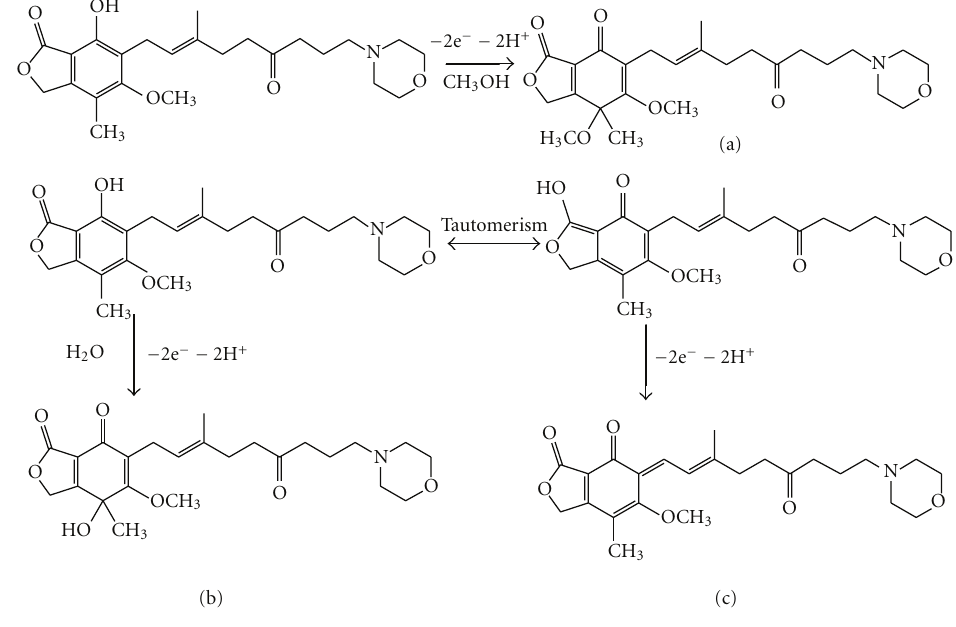
Scheme 1: Probable oxidation pathway for the electrochemical oxidation of MMF.